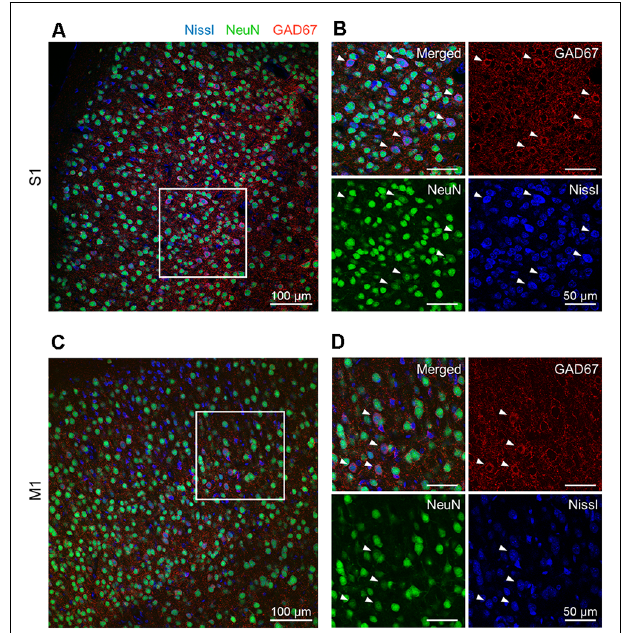
FIGURE 1 | Representative photographs of GAD67 and NeuN immunoreactivity in the S1 and the M1 of mice. (A) Representative image (1,024 × 1,024 pixels, 16-bit intensity, 20 × ) of a section of S1 immunostained with GAD67 (red) and NeuN (green) and counterstained with Nissl (blue). (B) Magnified image of the boxed area (white). High-magnification images of merged (top, left), anti-GAD67 (top, right), anti-NeuN (bottom, left), and Nissl (bottom, right). White arrowheads point to GAD67-positive cells. (C) The same as (A) , but for M1. (D) The same as (B) , but for M1. Abbreviations: S1, primary somatosensory cortex; M1, primary motor